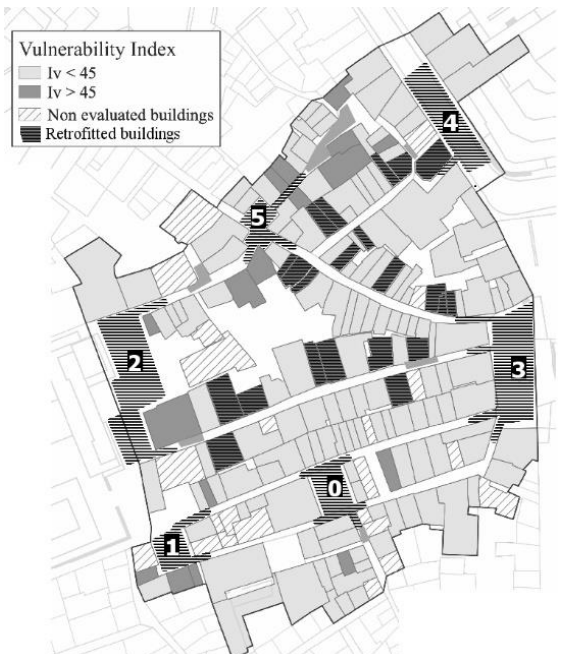
Figure 8. Open spaces usage at the end of the simulation in the SCENARIO C, by evidencing: assembly areas used by more than the 10% of arrived evacuees, and related access (dashed areas); main areas of spontaneously gathering with different marks to compare with the SCENARIO A results in Figure 3 (grey areas along the streets marked by *: similar position; +: placed near to a deleted assembly area; !: close to a new assembly